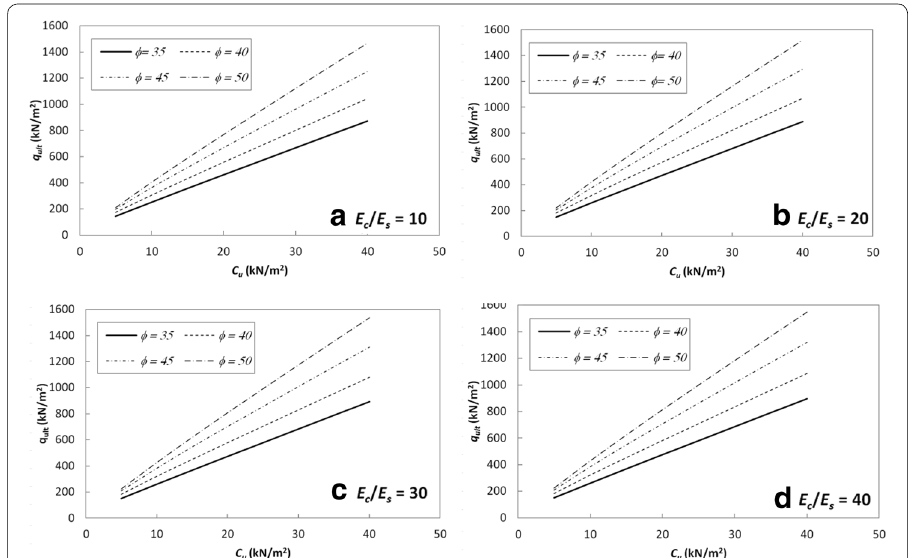
Fig. 7 Ultimate bearing capacity versus undrained shear strength